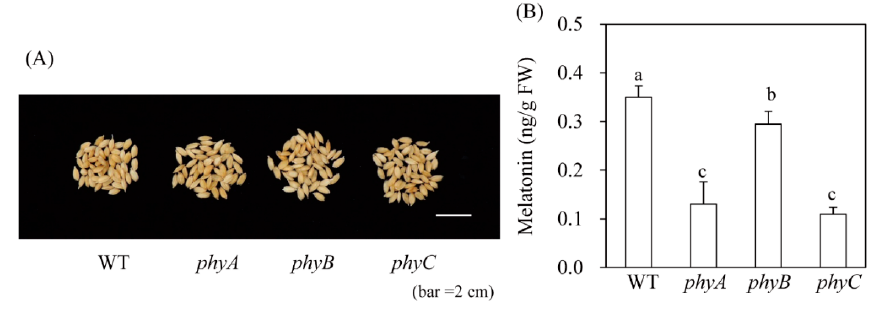
Figure 6. Seed melatonin levels in phy mutants. ( A ) Water-imbibed rice seeds after 9 h. ( B ) Melatonin levels in phy mutants. WT, wild type; FW, fresh weight. Di ff erent letters indicate significant di ff